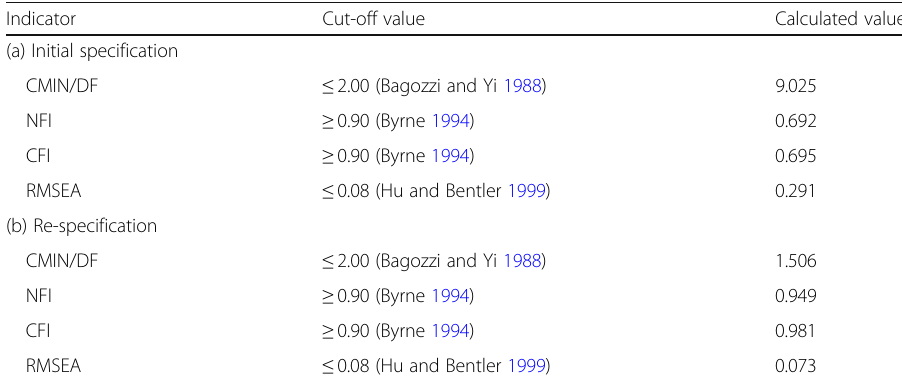
Table 6 H1 SEM model fit indicators Indicator Cut-off value Calculated